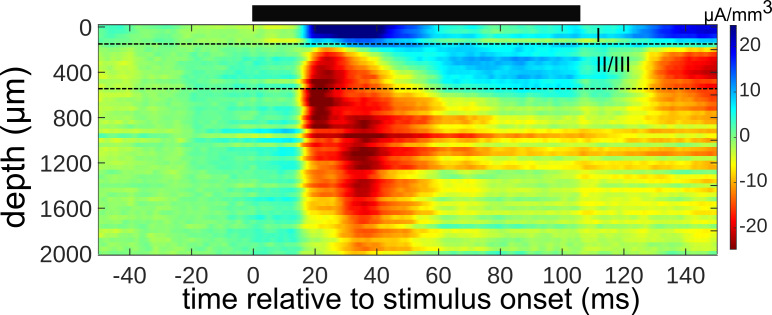
Determining cortical layers from an inverse Current Source Density (iCSD) map of electrophysiological responses.The iCSD shown was constructed from local field potential recordings of responses to tones presented near BF (±1/3 octave) in one microelectrode penetration. The black bar above the plot indicates stimulus presentation time. The depth (µm) relative to the cortical surface is plotted on the y-axis. The boundary between layers 1 and 2 (upper black dotted line) was inferred based on the reversal in the iCSD profile, and the boundary between layers 3 and 4 (lower black dotted line) was estimated to be 400 µm below the beginning of layer 2.